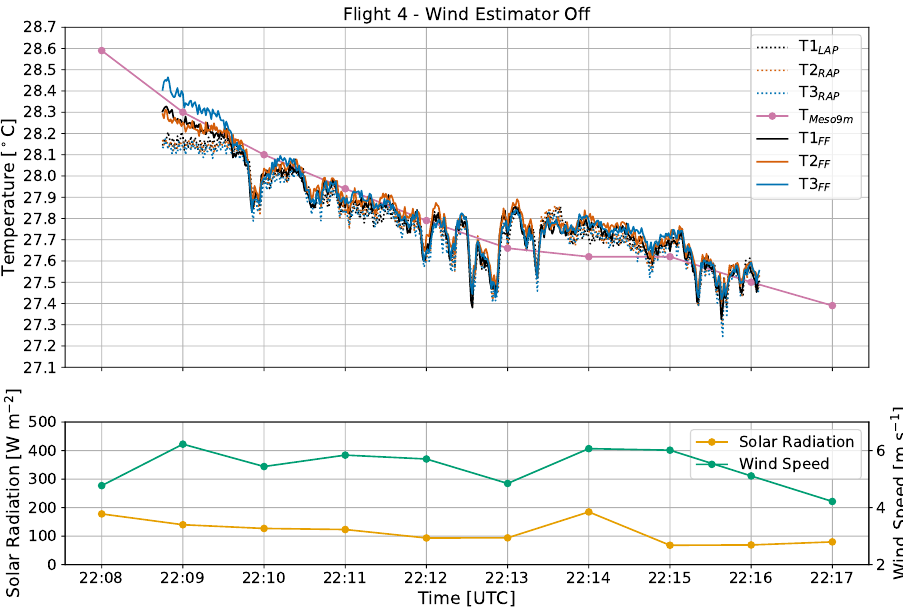
Figure 7. Time series of temperature [ ◦ C], solar radiation [W m − 2 ], and wind speed [m s − 1 ] from flight 4, with the same labeling conventions used as in Figure 6. The wind estimator was off and the CopterSonde was oriented 90 degrees counterclockwise from the oncoming wind and away from the